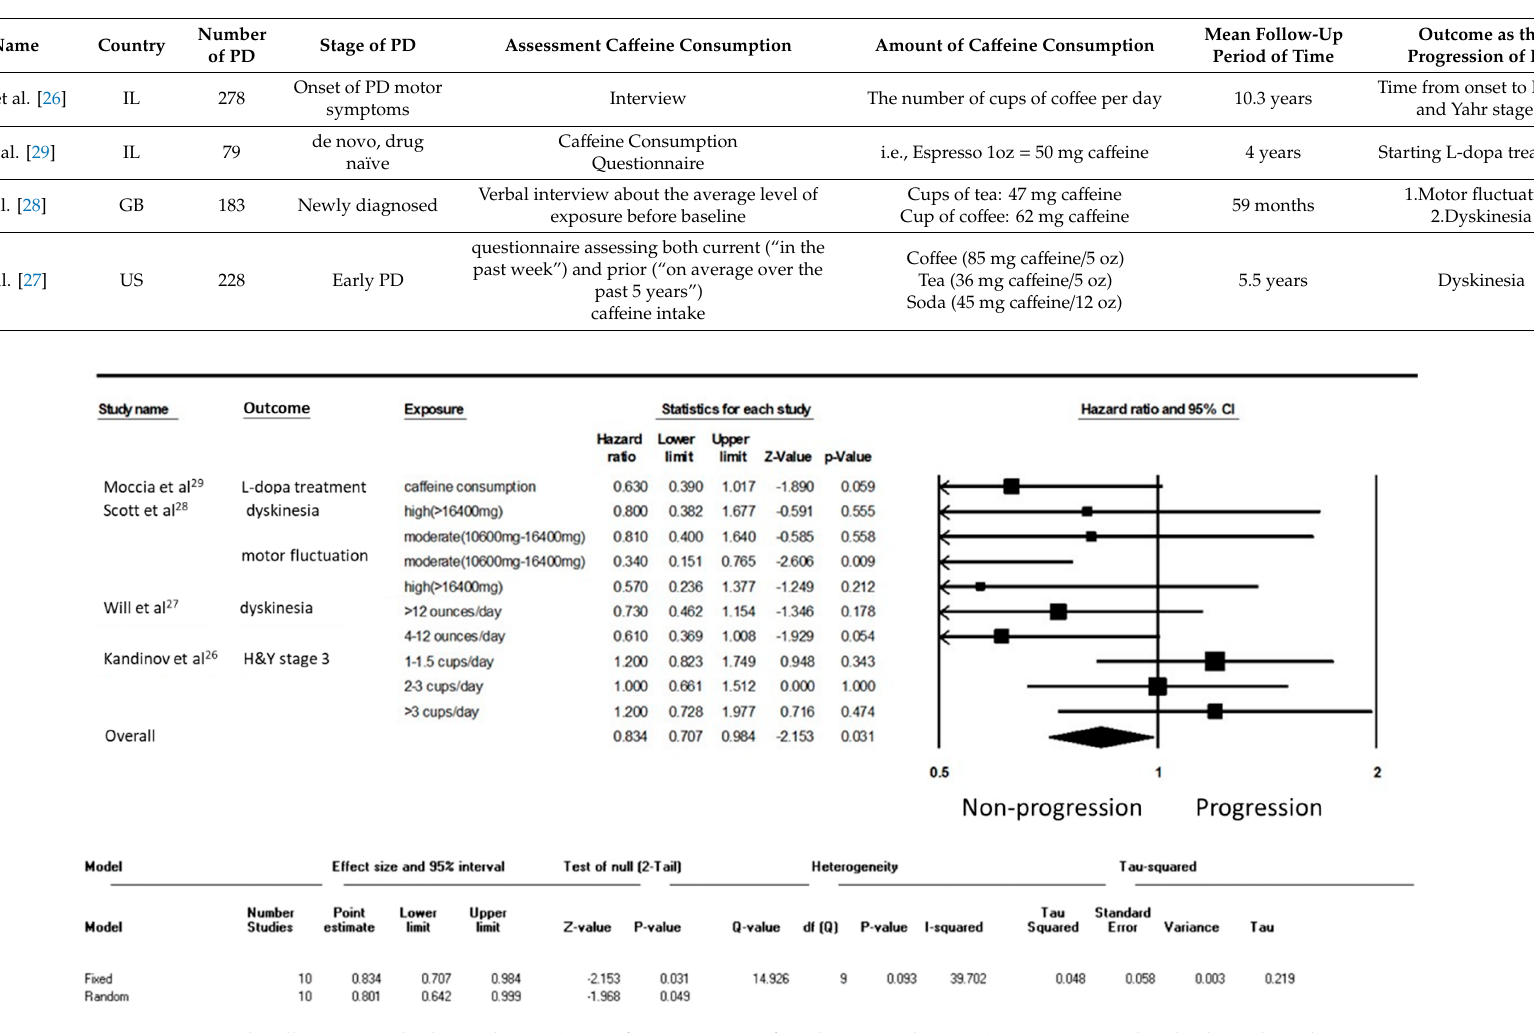
Table 2. List of the included studies on the progression of Parkinson’s disease (PD).